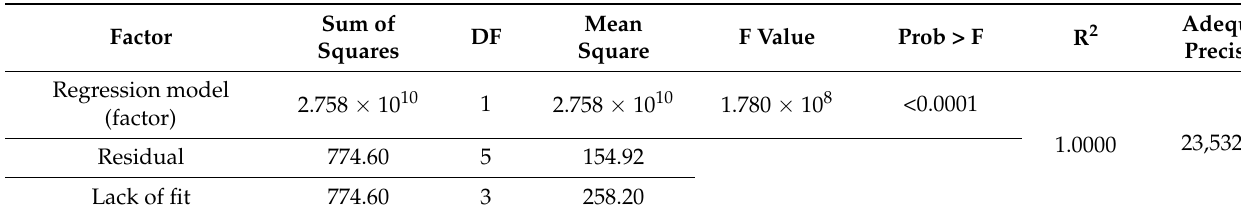
Table 2. Significant test results for the established regression model.